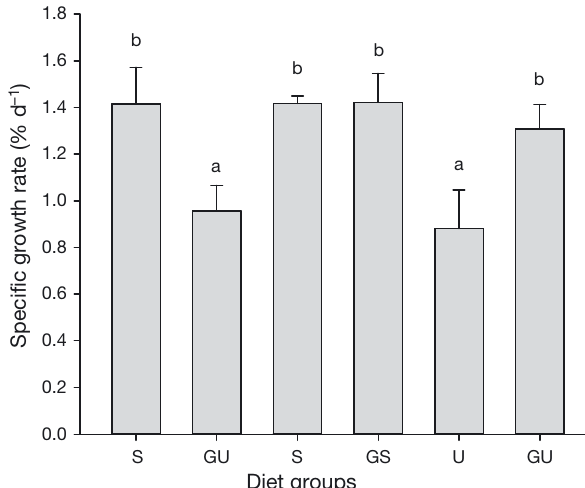
Fig. 2. Specific growth rates of Apostichopus japonicus in different diet groups. Error bars represent 1 SD (n = 3). Val- ues with different letters represent significant difference at the significance level of 0.05 (p < 0.05). See Fig. 1